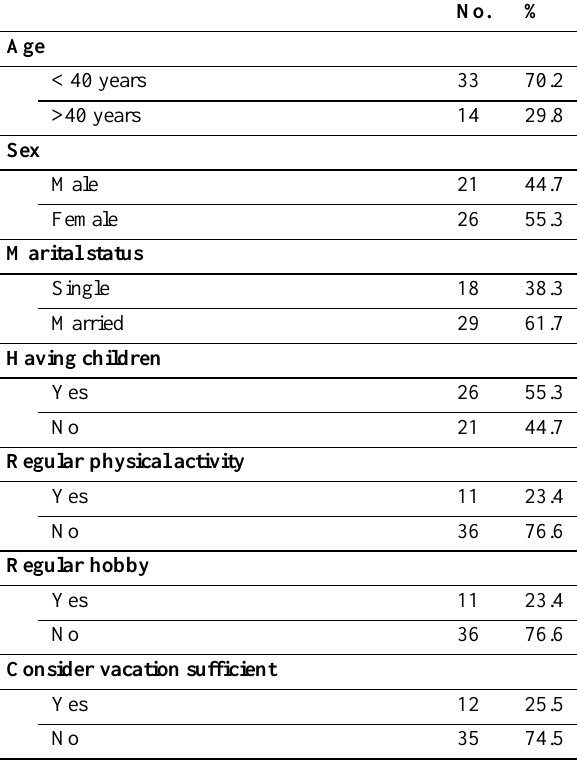
Table 2: Job characteristics of the study participants